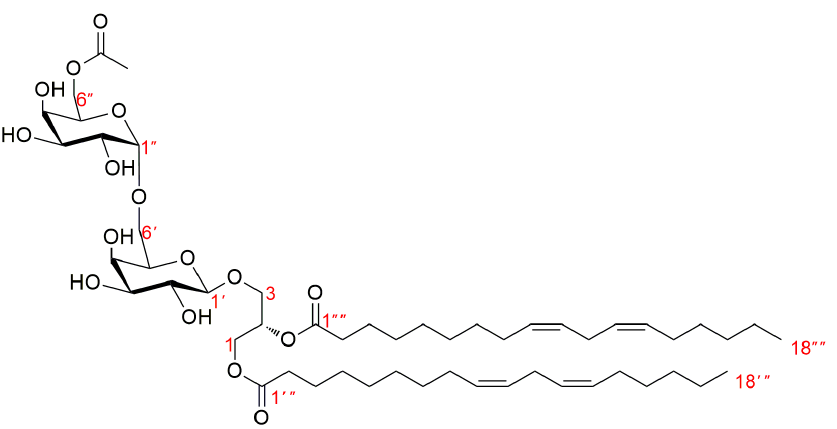
Figure 1. Chemical structure of compound 1 from Tubeufia rubra PF02-2.